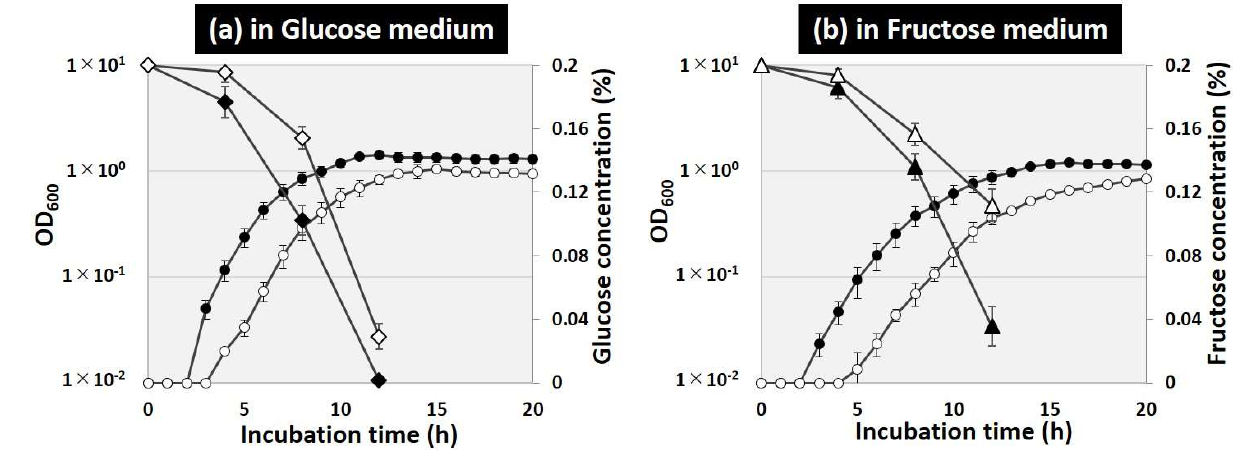
Figure 5. Effect of flhD deficiency on the growth curve and sugar consumption. E. coli BW25113 (closed symbols) and its flhD mutant JW1881 (open symbols) were grown in M9 media with 0.2% glucose ( a ) or 0.2% fructose ( b ). Cell density (circles in a , b ) was monitored every hour and plotted along the time course. The concentrations of glucose (rhomboids in a ) and fructose (rhomboids in b ) were monitored every 4 h for up to 12 h.